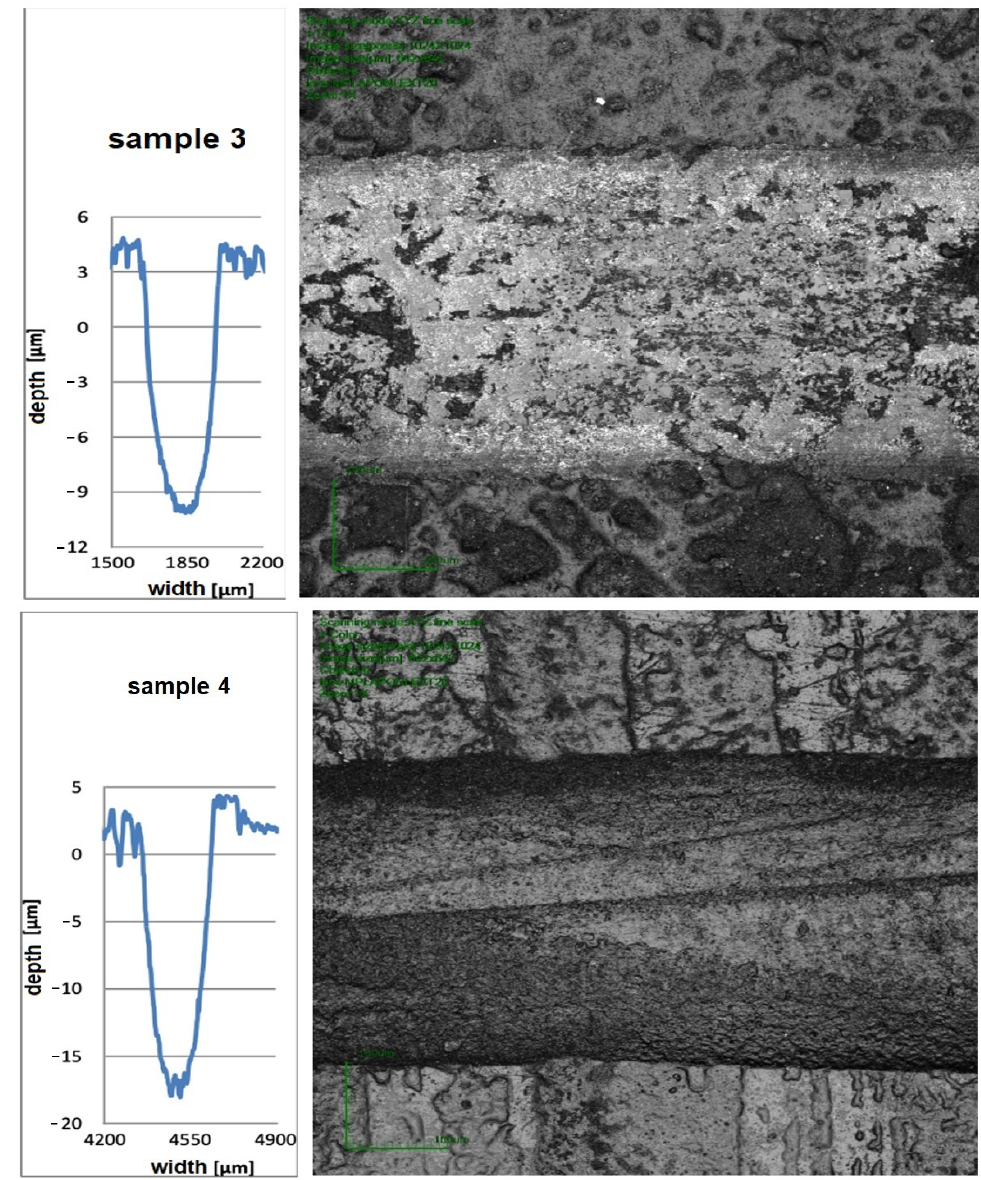
Figure 7. Microscopic examinations.